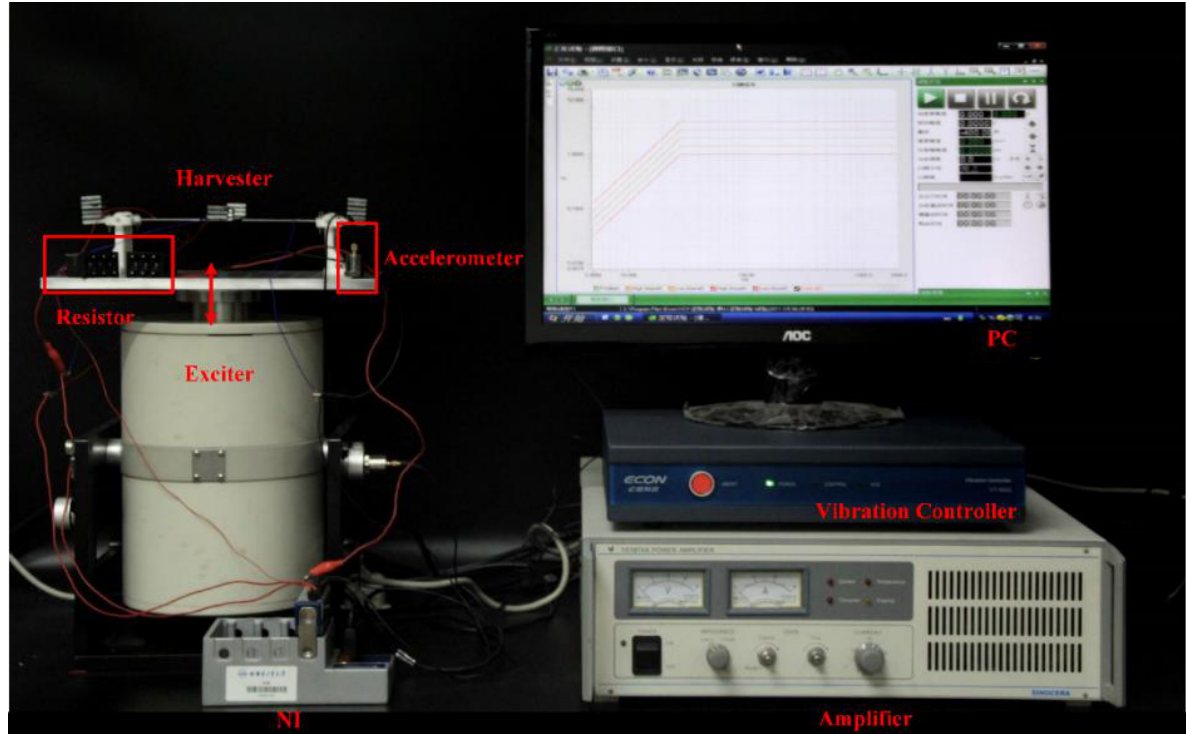
Figure 6. Photograph of the experimental testing system for energy harvesting.